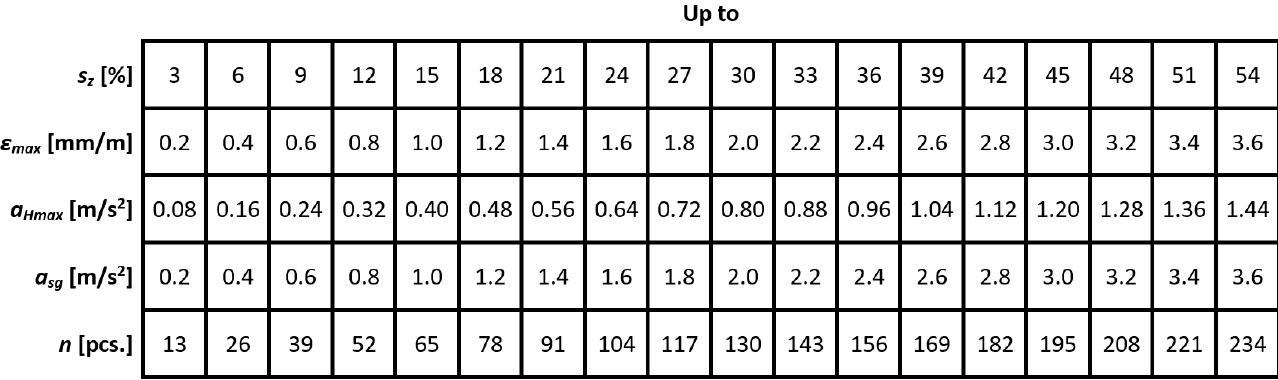
Figure 4. Division of predictor variables ( s z , ε max , a Hmax , a sg , n ) according to fixed intervals.